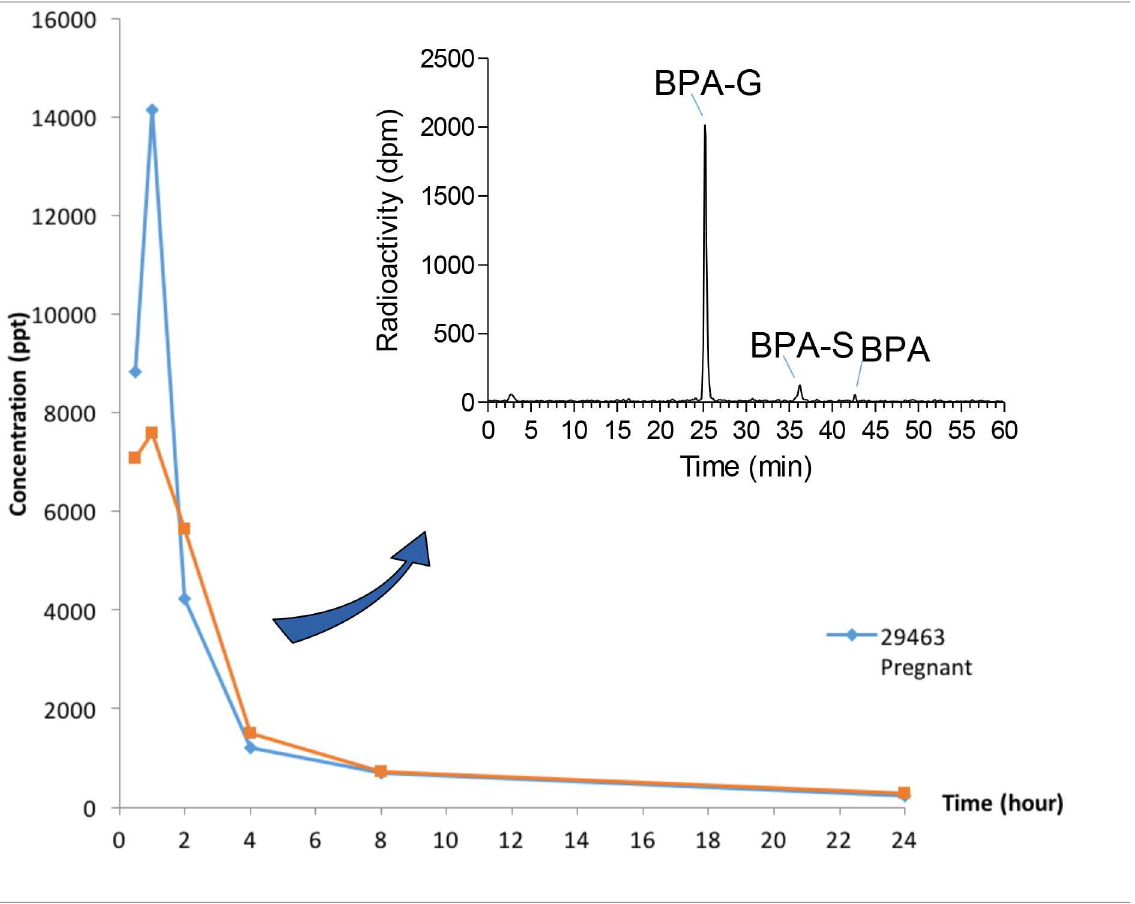
Fig 2. 0–24 hr serum levels of BPA residues measuredin a pregnant (blue) and a non pregnant (orange) Rhesus macaque dosed with 7.78 μ g/kg and 4.45 μ g/kg 3 H-BPA, respectively. Results are expressedin pg/g (ppt) of BPA equivalents. A typical radio-HPLC profile corresponding to the analysisof serum radioactivity is displayedat the top right of the figure.